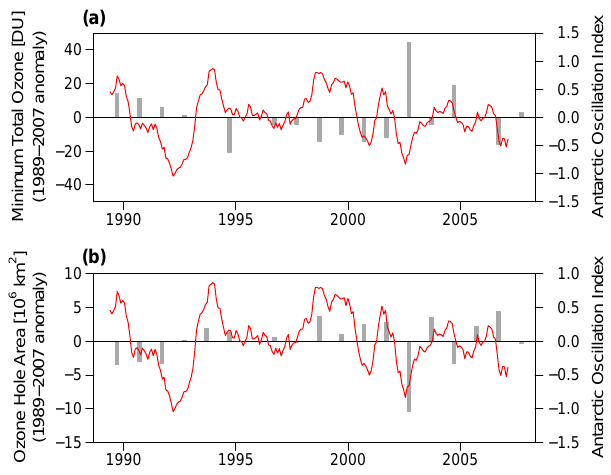
Fig. 8. 13-month averages of the Antarctic Oscillation Index (red) in comparison with (a) the anomaly of the absolute minimum mean column ozone observed between 21 September and 16 October based on the period 1989–2007 (grey bars) and (b) the anomaly of the average area of the southern ozone hole between 7 Septem- ber and 13 October based on the period 1989–2007 (grey bars). The ozone hole area and minimum mean column ozone are based on TOMS data provided by NASA/GSFC (http://ozonewatch.gsfc. nasa.gov/meteorology/annual data.html). All panels are for 1989–